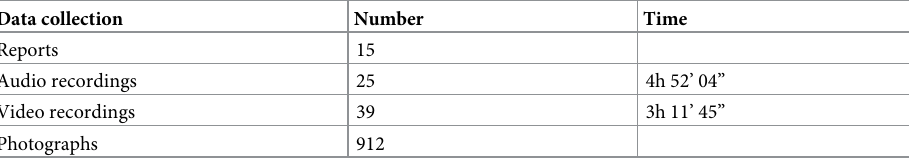
Table 1. Data collection